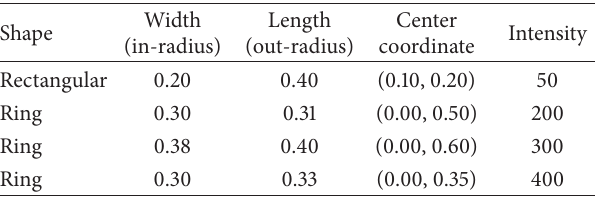
Figure 2: The initial distribution of the reconstruction. Table 1: Geometric parameters of the phantom